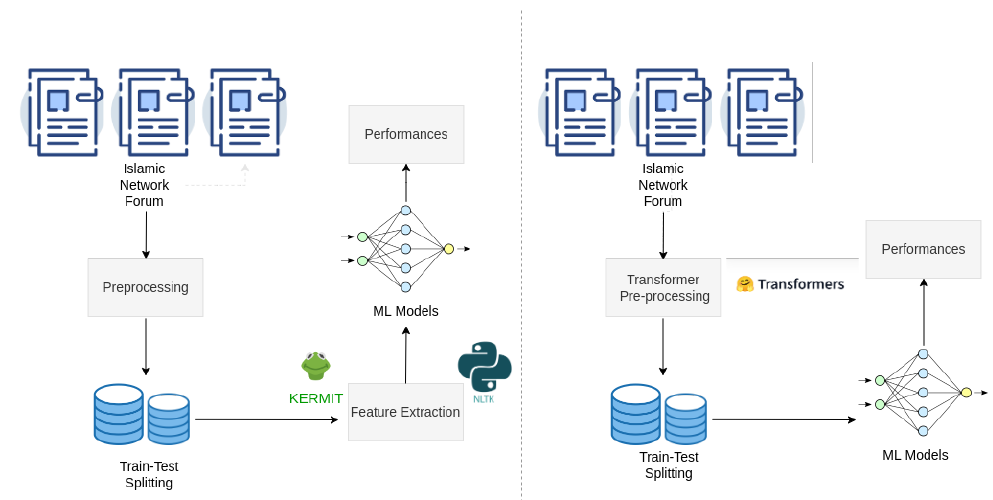
Figure 4. Diagram of the proposed model development pipeline. ( a ) Style- and lexical-based features and KERMIT. ( b ) Transformer